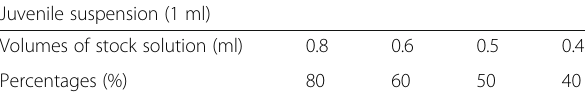
Table 1 Percentages of the different volumes of the stock solution in the juvenile mortality test